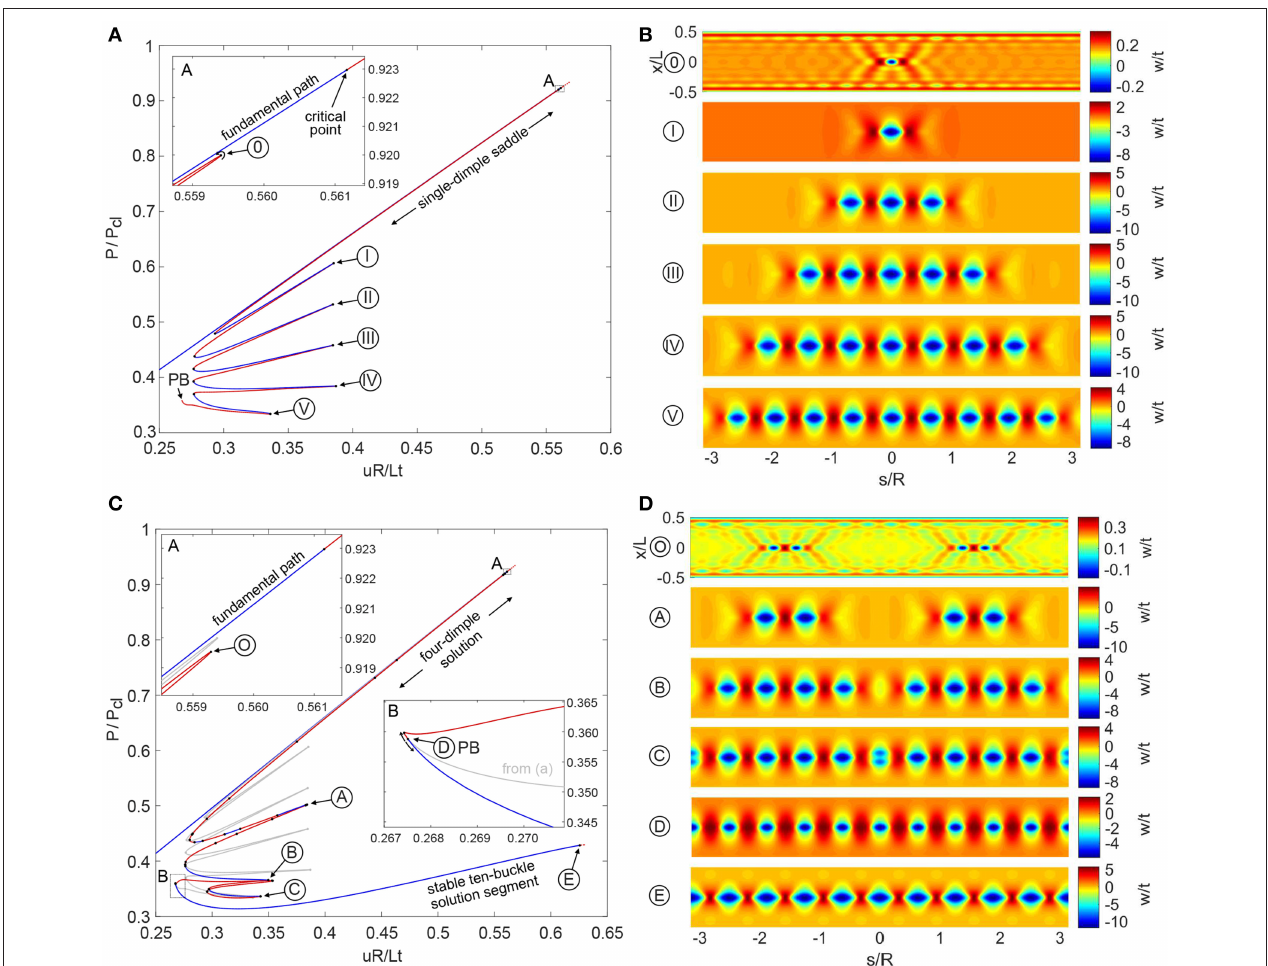
FIGURE 7 | (A) Equilibrium path of a single-dimple post-buckling solution growing sequentially around the cylinder circumference through a series of destabilizations and restabilizations known as cellular buckling (or snaking). (B) Deformation mode shapes of the displacement component normal to the cylinder wall ( w ) over the cylinder domain ( x is the axial coordinate and s the circumferential coordinate) for different points 0–V in (A) . (C) Equilibrium path of a four-dimple post-buckling solution growing sequentially through cellular buckling. The single-dimple snaking solution in (A) connects to this path at a pitchfork bifurcation (see point D in inset B ). (D) Radial deformation mode shapes over the cylinder domain for different points O–E in (C)